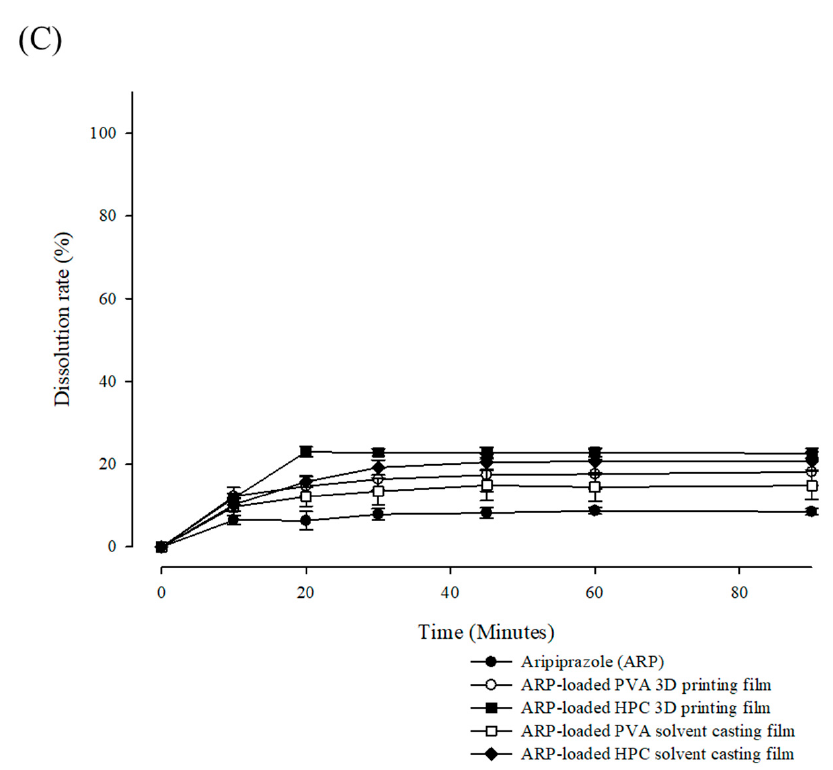
Figure 8. Dissolution profiles of aripiprazole (ARP) and ARP-loaded film formulations in different bioequivalent mediums, ( A ) pH 1.2 USP buffer, ( B ) pH 4.0 USP buffer, and ( C ) pH 6.8 USP buffer ( n = 3).